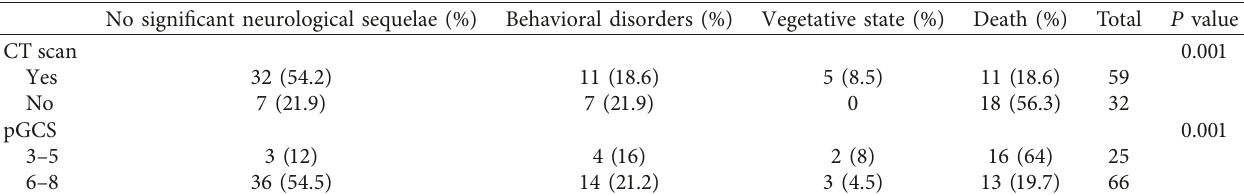
Table 5: Outcomes by CT scan availability and initial pediatric Glasgow Coma